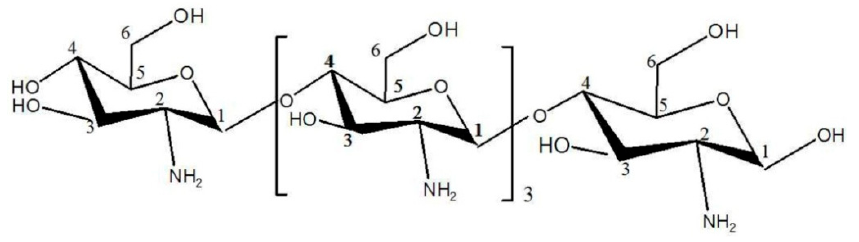
Figure 5. The structure of oligochitosan DP5, which is composed of five glucosamines.